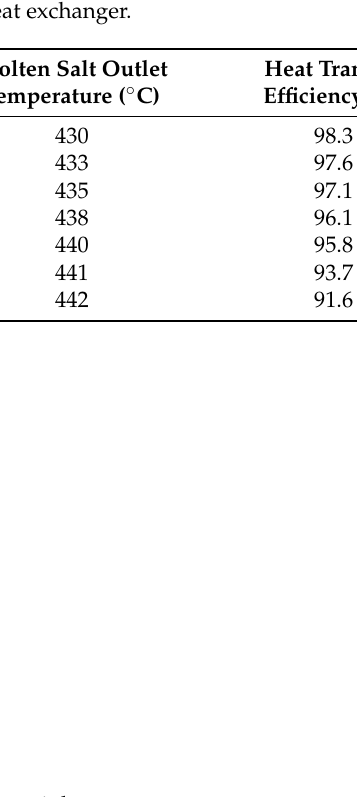
Figure 11. Heat exchanger efficiency change with steam inlet temperature.